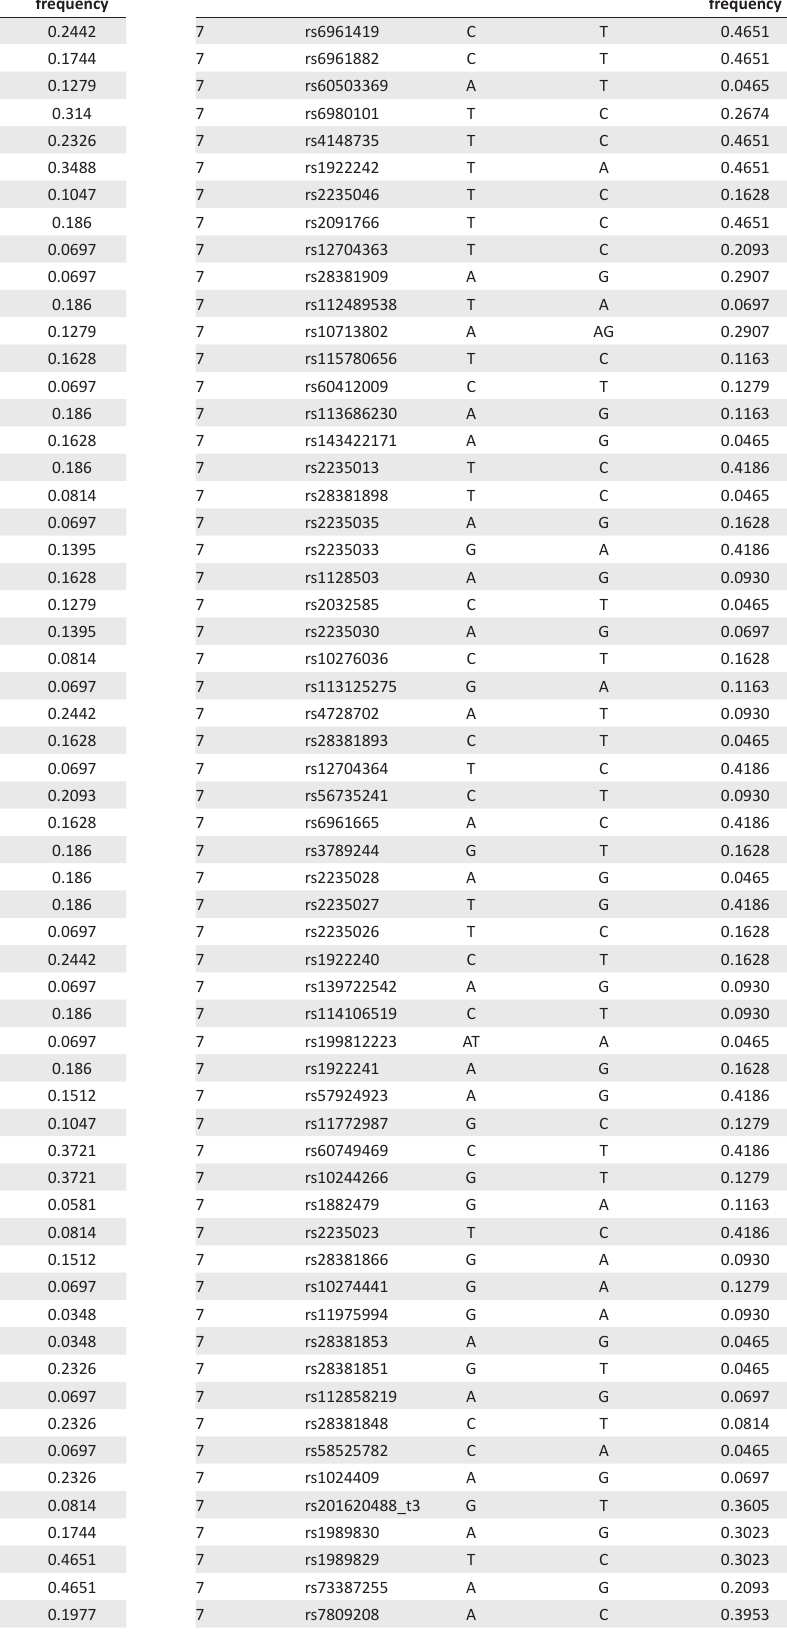
Table 1-A1 (Continues...): Minor allele frequencies for 1846 polymorphisms in 43 black South Africans. Chromosome Polymorphism Minor allele